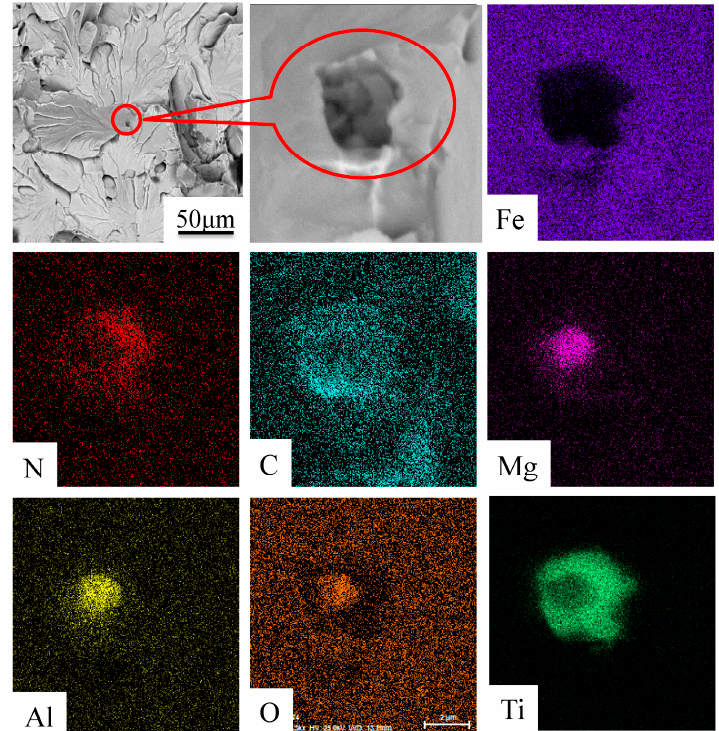
Figure 3. Element mapping of MgAl 2 O 4 + Ti(C, N) inclusion found at initiation sites in steel 1.